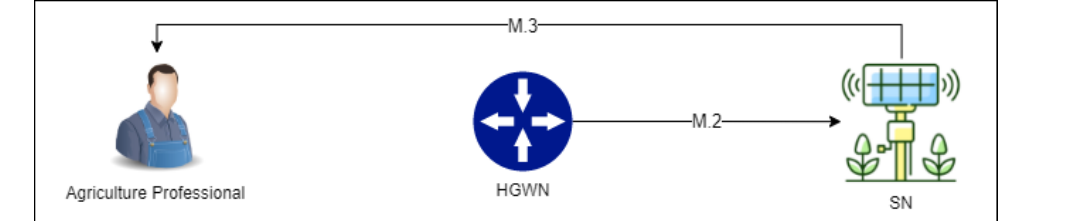
Figure 9. Authentication phase (Case 1).